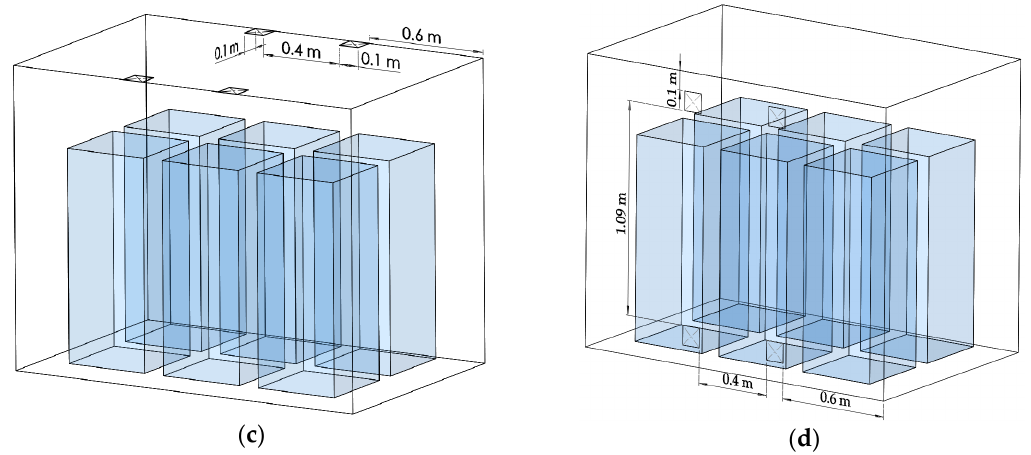
Figure 5. Specification of different fan locations: ( a ) L0; ( b ) L1; ( c ) L2; and ( d ) L3.